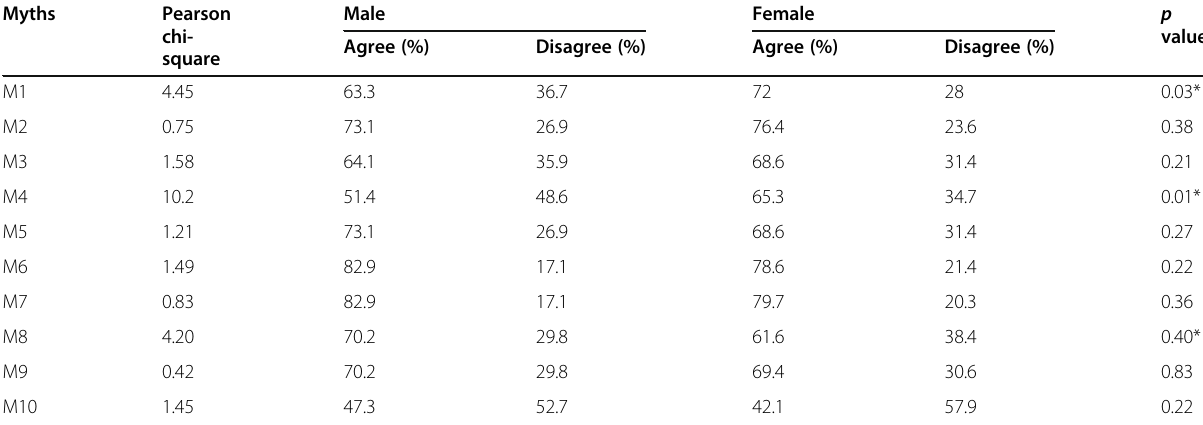
Table 4 Evaluation of the responses based on gender Myths Pearson Male Female chi- square